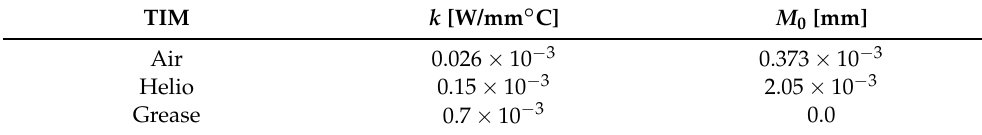
Figure 12. Model analyzed in this example where the influence of different TIMs is analyzed. Table 7. Thermal interface material properties used to calculate the thermal contact resistance ( R TC